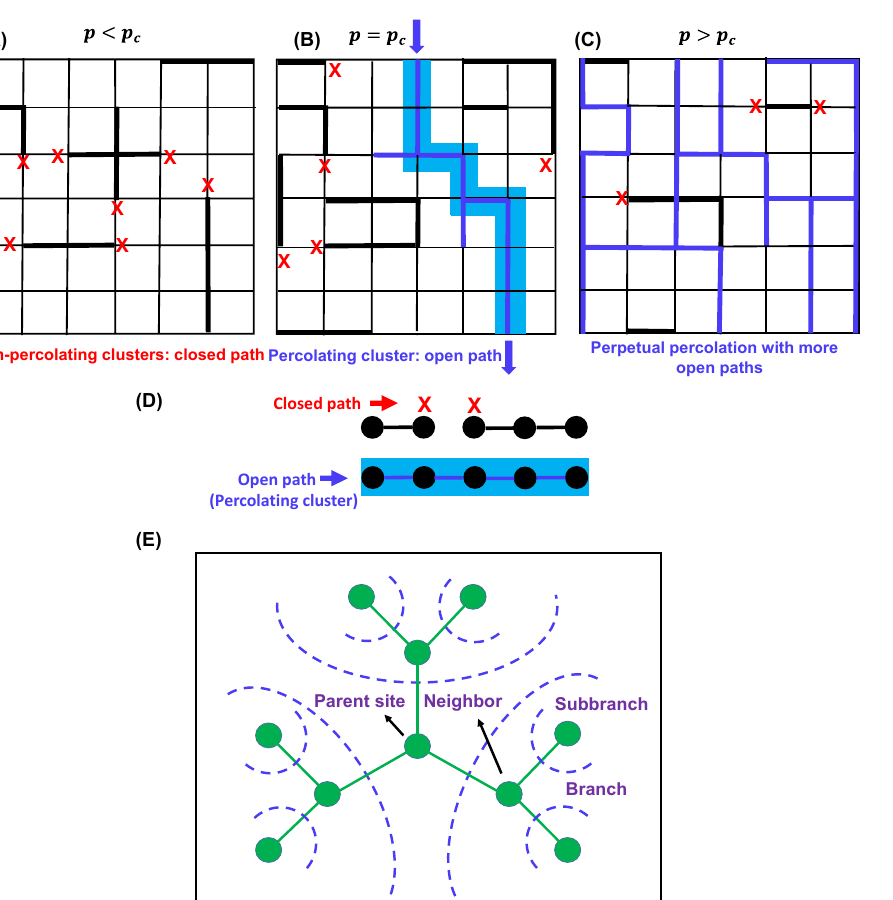
Figure 3. Three lattices with different percolation thresholds ( p c ) conditions: ( A ) p < p c , ( B ) p = p c , and ( C ) 𝑝 > 𝑝 (cid:3030) . Percolation occurs when 𝑝 = 𝑝 (cid:3030) . In ( B ), the bond connectivity is shown by blue lines, and the percolating cluster is shown in light blue shade. Red crosses describe closed paths. In ( C ), the bond connectivity is shown by blue lines, red crosses describe closed paths, and the clusters are not shown for simplicity. ( D ) Bond percolation in one dimension. The vertices are shown by black circles, and the edges (bond connectivity) are shown by black lines. Red cross describes the closed paths, and blue line describes the open paths for percolation. Percolating cluster is shown by light blue shade. ( E ) Typical sketch of a Bethe lattice with coordination number 3. Parent site, branches, and subbranches are shown by olive circles. The blue dashed lines depict possible directions of branching.